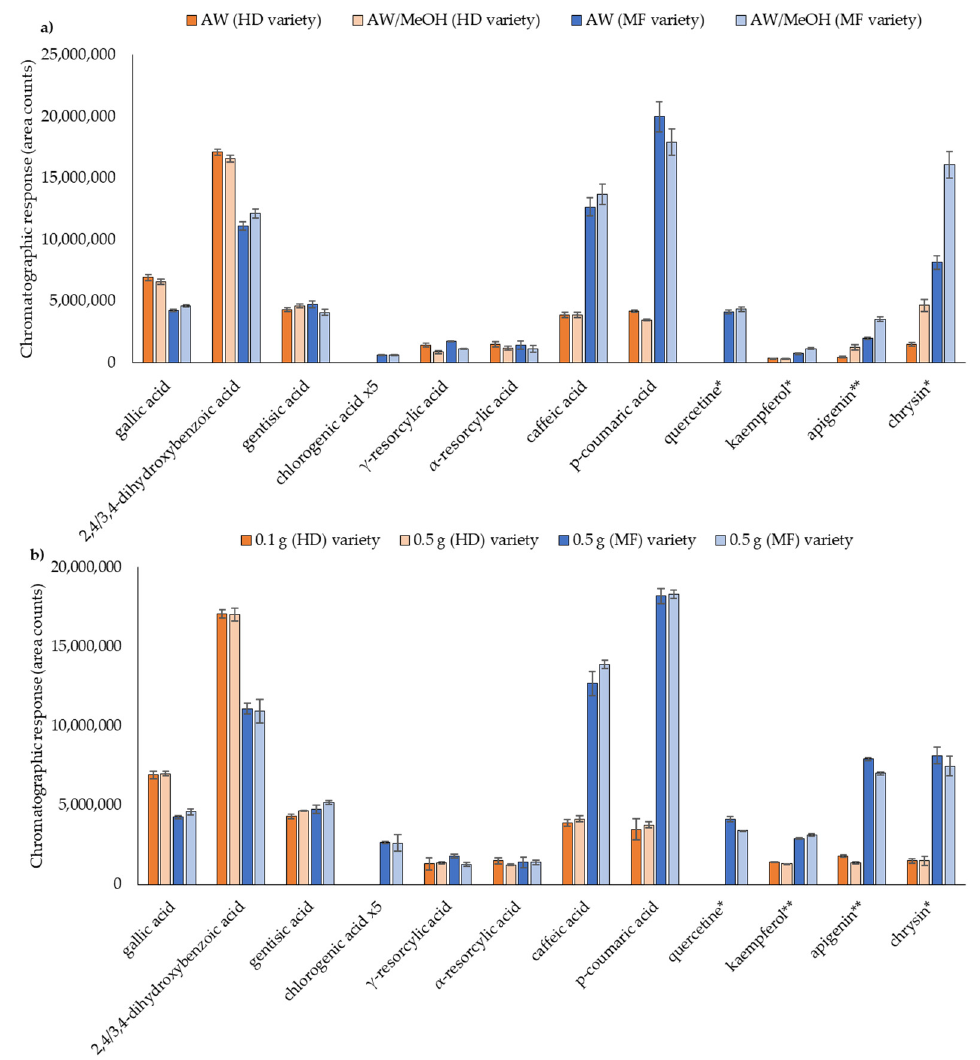
Figure 4. Optimization of the ( a ) extraction solvent; ( b ) sample size for two honey varieties (HD10 and MF32). * Response multiplied ×5; **multiplied ×20.